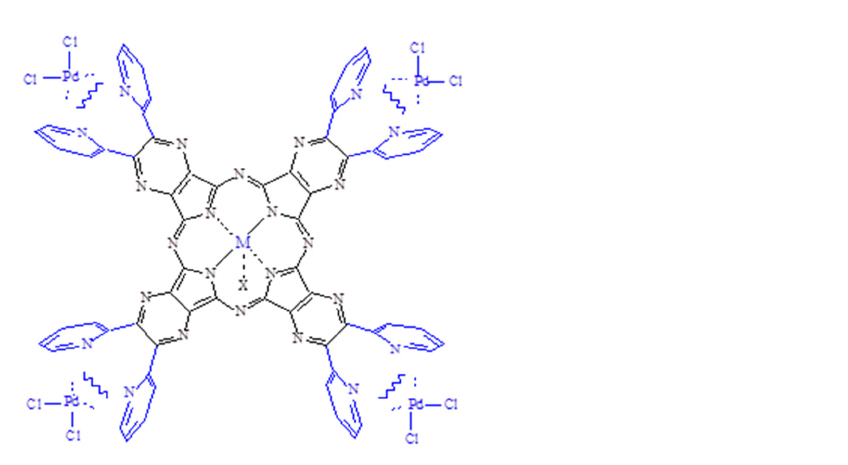
Figure 1. Schematic view of the mononuclear and heteropentanuclear macrocycles [Py 8 TPyzPzMCl] and [(PdCl 2 ) 4 Py 8 TPyzPzMCl)] implying external “py-py” coordination (M = Al III , Ga III ; X = Cl) (water